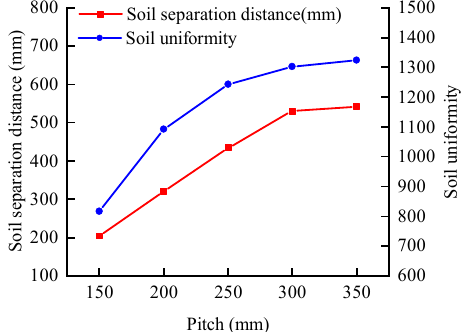
Figure 11. Relationship curves between pitch and D W , E.